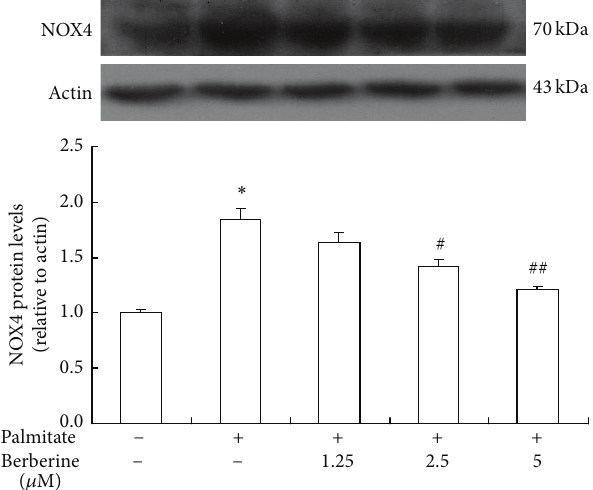
Figure 6: The effects of berberine on protein expression of NOX4 in HUVECs exposed to palmitate. HUVECs were cultured in RPMI- 1640 containing 0.5 mmol/L palmitate and treated with 1.25, 2.5, and 5 𝜇 mol/L berberine for 24 h. Total protein was prepared and separated by SDS-PAGE. Expression and relative quantification of NOX4 protein levels were expressed relative to the amount of actin. Control group was not stimulated with 0.5 mmol/L palmitate. Data are expressed as mean ± S.E.M. All presented results are representa- tive of at least 3 independent experiments. ∗ 𝑃 < 0.01 versus control group, # 𝑃 < 0.05 versus palmitate treated group, and ## 𝑃 < 0.01 versus palmitate treated